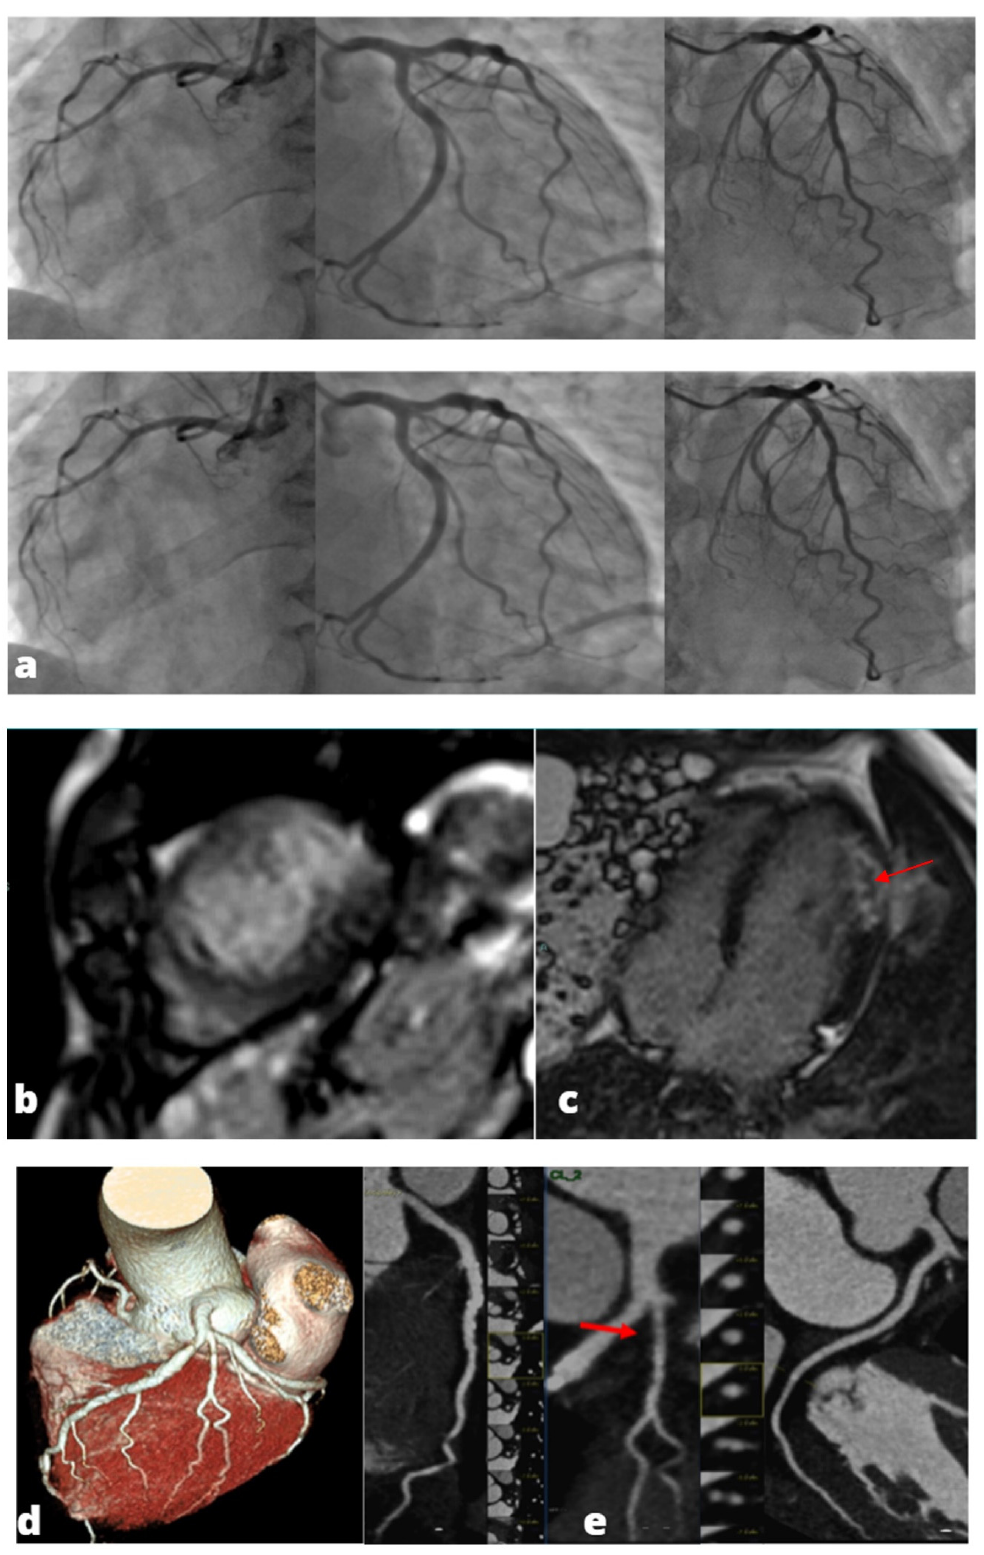
Figure 3. MINOCA-Miocardial Infarct non obstructive coronaries. The patient presented to the emergency department with acute chest pain, ECG and cardiac enzymes suggestive of STEMI in the lateral wall of the left ventricle. The patient was readily referred to coronary angiography and car- diac catheterization showed absence of obstructive stenoses in the coronary tree ( a ). One day later a cardiac MRI was performed demonstrating a subacute ischemic scar in the lateral wall of the me- dium-apical left ventricle ( b -LGE short axis view, c -LGE four chambers view). In the context of transmural late gadolinium enhancement, a constantly hypointense central area is present, repre- senting a microvascular obstruction zone (red arrow). A cardiac CT was subsequently performed in order to assess coronary wall features and the presence of atherosclerosis. CT images in volume rendering ( d ) and multiplanar oblique reconstruction ( e ) demonstrated a non-calcified atheroscle- rotic alteration in an obtuse marginal vessel, serving the infarcted zone. A partly calcified athero- sclerotic pathology was present in the anterior descending artery. 5. Takotsubo Cardiomyopathy Takotsubo cardiomyopathy (TTC), also known as stress cardiomyopathy is an acute transient left ventricle dysfunction in which there is a sudden and reversible myocardial stunning in the absence of occlusive coronary artery disease [43]. TTC is usually triggered by physical or emotional stress in one-third of the cases. Clinically, it mimics acute myo- cardial infarction and patients typically refer chest pain and/or dyspnea. It is responsible for about 1% to 2% of patients presenting with acute myocardial injury and it often pre- sents as a MINOCA “mimic”[43]. TTC predominantly affects postmenopausal women (90%) and accounts for approximately 5–6% of female patients presenting with suspected ST-elevation myocardial infarction (STEMI). Therefore, cardiac imaging tools have a cru- cial role in these patients. Coronary angiography is necessary to exclude pathological cor- onary stenosis and CCTA should be considered as an alternative diagnostic tool in the case of low or medium pre-test risk patients because of its high negative predictive value. On the other hand, transthoracic echocardiography is the first non-invasive imaging mo- dality for an early evaluation of left ventricle systolic and diastolic function [44]. CMR is indicated in all patients presenting with suspected Takotsubo. CMR allows for the multiparametric quantification of myocardial tissue characteristics such as the ab- sence of late gadolinium enhancement (typically) and of late enhancement on delayed contrast sequences. These findings differentiate Takotsubo cardiomyopathy from anterior STEMI in which necrosis in the wall is present in most patients even when there is no- reflow or microvascular obstruction [45,46]. CMR detects myocardial edema on T2-STIR that directly relates to the water content in the myocardial wall. In Takotsubo cardiomy- opathy, edema is typically located in the apical mid-ventricular planes, sparing the basal plane, and matches the wall-motion abnormalities seen on cine MRI [45–48]. Less frequent can be the reverse presentation (reverse Takotsubo syndrome) where the basal left myocardium can be affected (Figure 4).